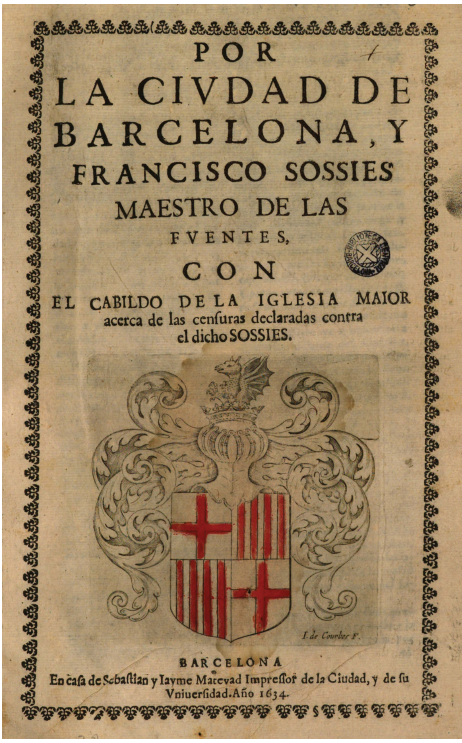
Figure 3. First page of the leaflet “Por la civdad de Barcelona y Francisco Sossies, maestro de las fventes, con el Cabildo de la Igle- sia Maior acerca de las censuras declaradas contra el dicho Sossies”, 1634 (AS8). Source: F.Bon. 10964, Biblioteca de